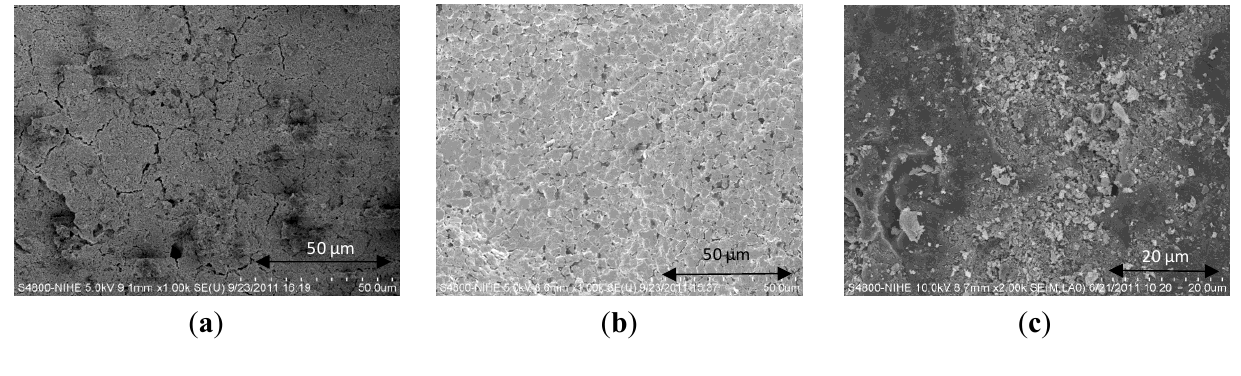
Zr O /cordierite samples prepared by ( a ) 0.2 0.8 2